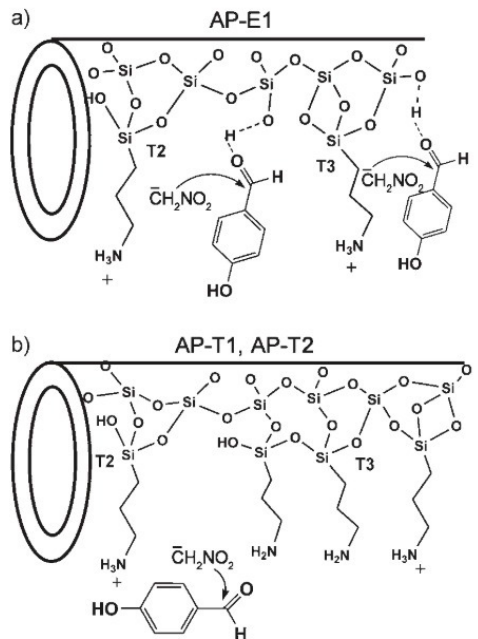
Figure 15. Reaction mechanism to explain the enhanced efficiency of AP-E1 ( a ) in the Henry reaction relative to AP-T1 and AP-T2 ( b ). The presence of a significant number of spatially isolated silanol groups in AP-E1 leads to activation of the carbonyl group of benzaldehyde for nucleophilic attack. Reproduced with permission from [23]. Copyright 2007 Wiley-VCH Verlag GMBH & Co. KGAA, Weinheim.